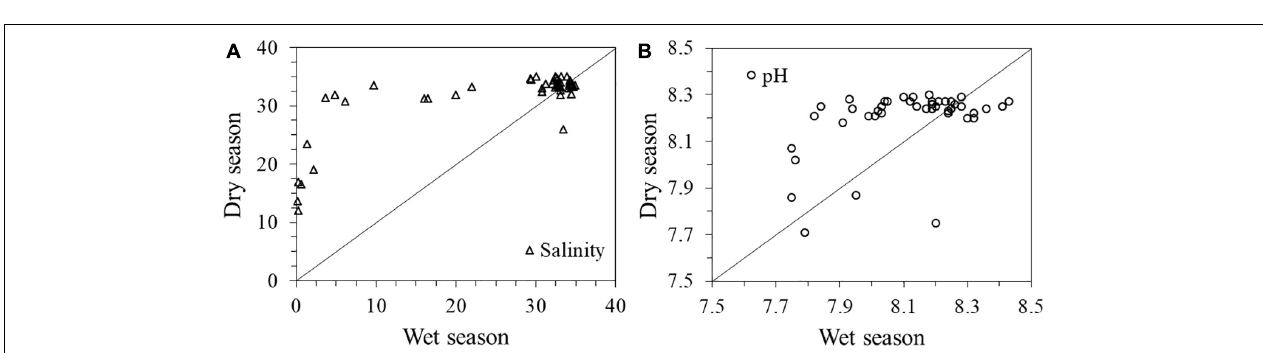
FIGURE 6 | Plots of panel (A) seawater 228 Ra activity vs. distance offshore at three transect A1–A3, and (B) the ratio of NO 3 − / 228 Ra, DOC/ 228 Ra, and DIC/ 228 Ra in coastal groundwater.